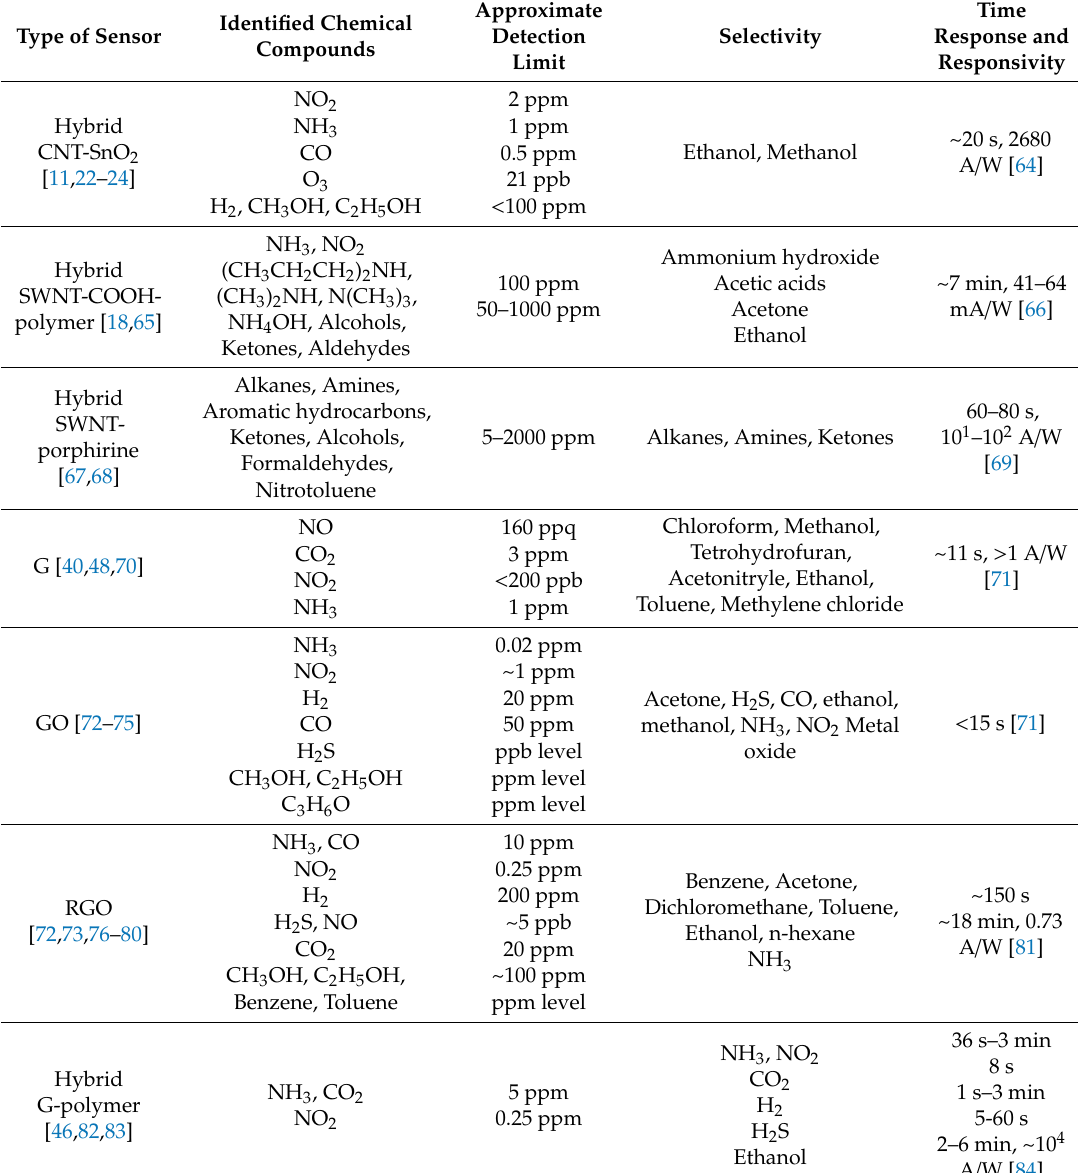
Table 1. A summary of properties along with an approximate detection limit for selected compounds, sensors based on graphene and its oxides, as well as hybrid materials of graphene and carbon